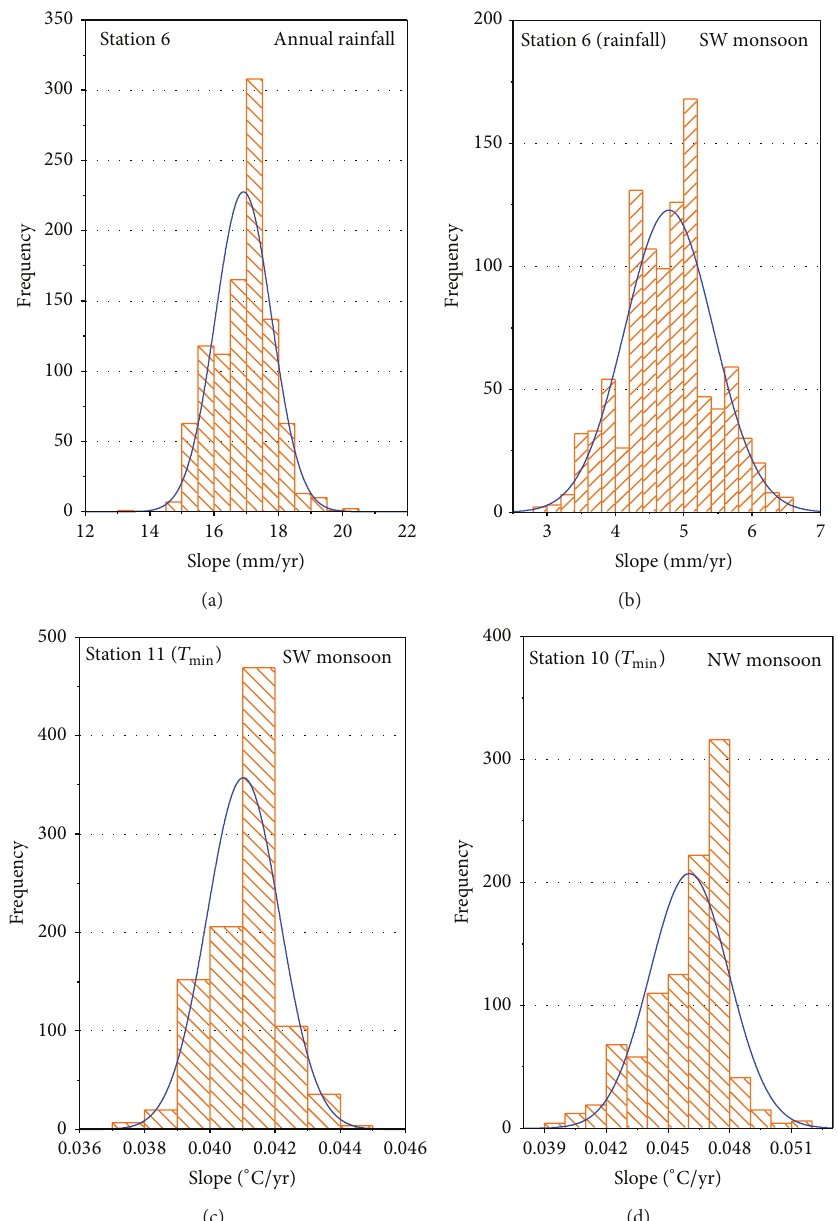
Figure 8: Examples of histogram of bootstrap slopes in significant trend for annual and seasonal temperatures ( 𝑇 Max , 𝑇 Min ) and